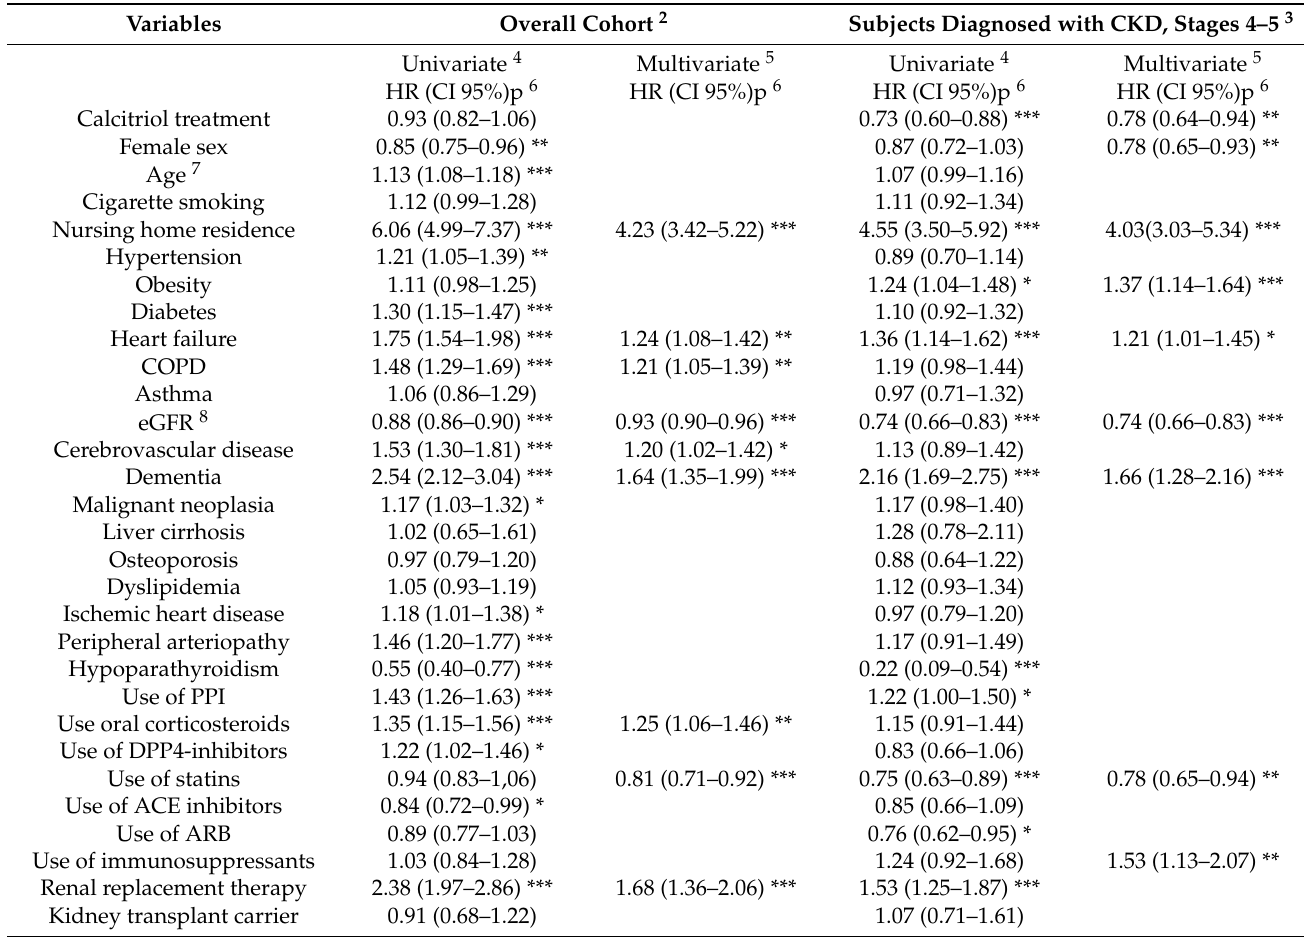
Table 2. Variables associated with SARS-CoV2 infection 1 in patients on calcitriol treatment and matched controls.